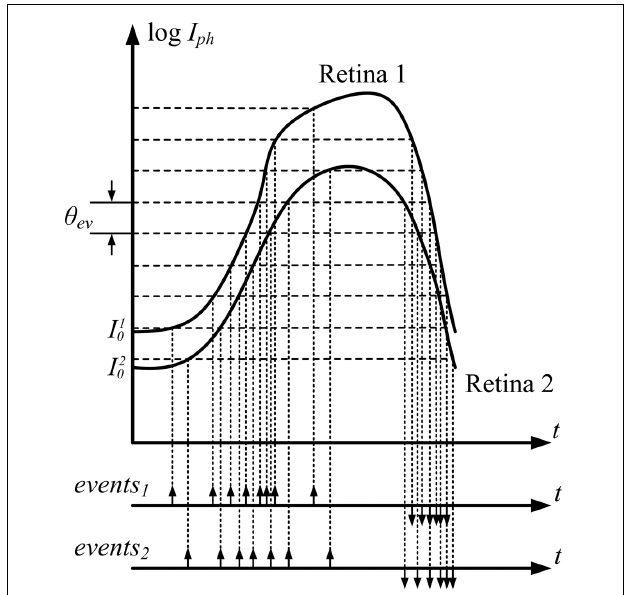
FIGURE 1 | Data driven asynchronous event generation for two equivalent pixels in Retina 1 and Retina 2. Because of intra-die pixel mismatch and inter-die sensor mismatch, both response curves